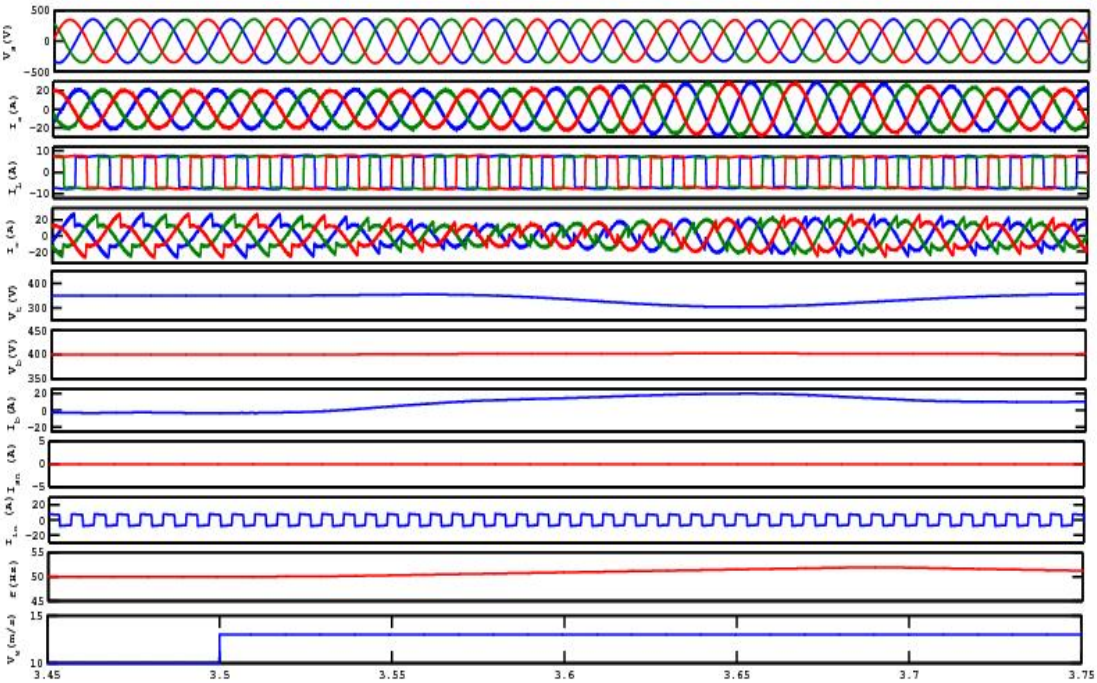
Designs 2021 , 5 , x FOR PEER REVIEW 16 of 20